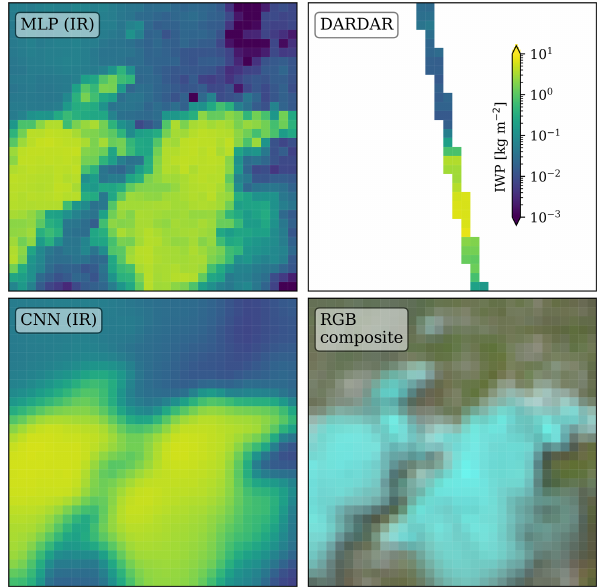
Figure 12. IWP retrievals (same colour scale) from a sample where the CNN may smooth out the retrieved value. The RGB composite is generated with channels 1 (blue), 2 (green), and 3 (red), using the natural_color composite from Satpy (Raspaud et al.,